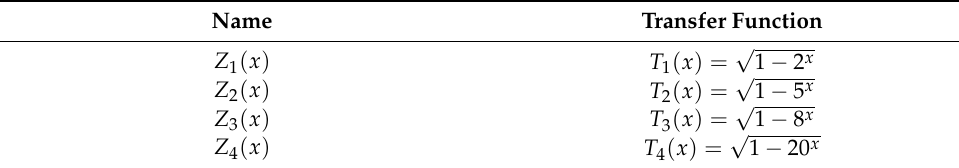
Table 5. The expressions of the Z-shaped families of transfer